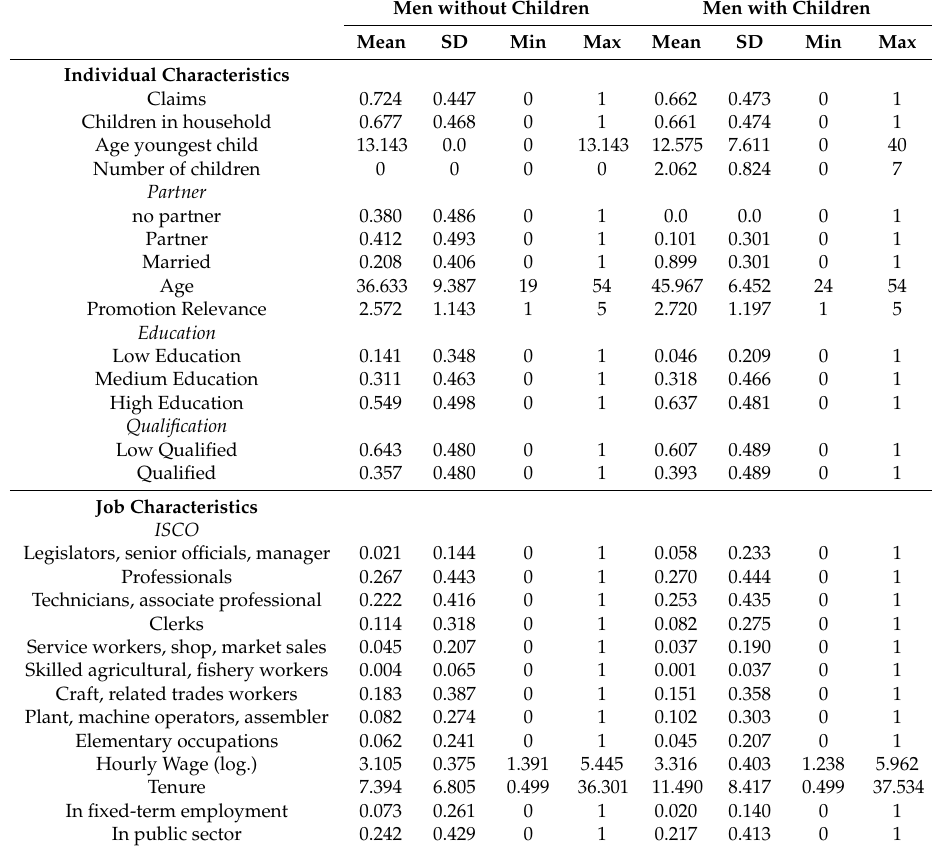
Table 1. Means and Standard Deviations of study variables for men ( N =